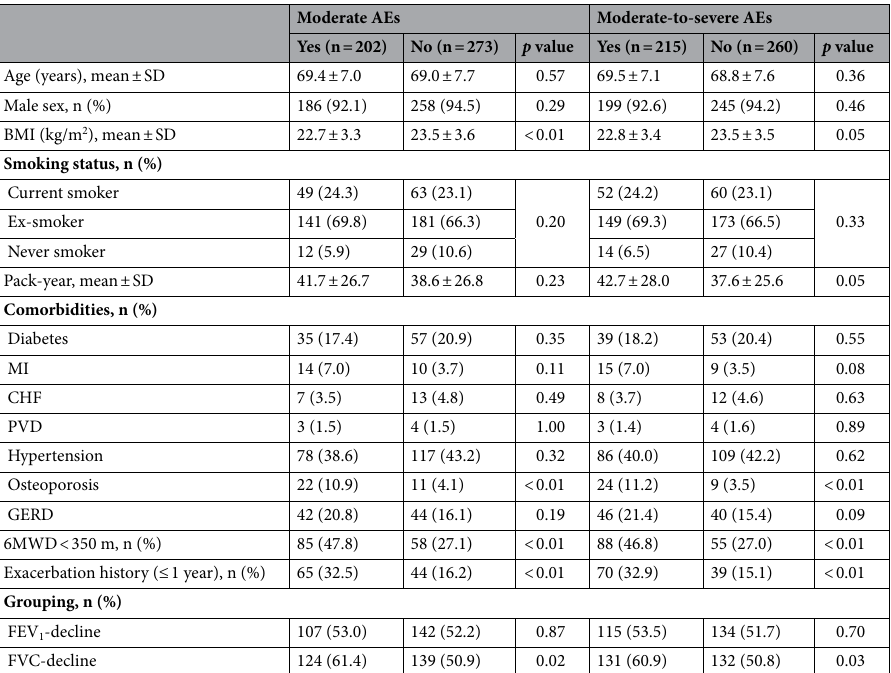
Table 3. Clinical characteristics according to exacerbations in asthma-COPD overlap. Clinical characteristics were compared between the two groups, such as the patients who experience the exacerbations or not. In the comparison of moderate AEs, BMI, underlying osteoporosis, and percentage of FVC-decline group were significantly different between the “Yes” group and “No” group. In the comparison of moderate-to-severe AEs, underlying osteoporosis and percentage of FVC-decline group were significantly different between the “Yes” group and “No” group. AEs acute exacerbations, BMI body mass index, CHF congestive heart failure, COPD chronic obstructive pulmonary disease, FEV 1 forced expiratory volume in one second, FVC forced vital capacity, GERD gastro-esophageal reflux disease, MI myocardial infarction, PVD peripheral vascular disease, 6MWD 6-min walking distance, SD standard